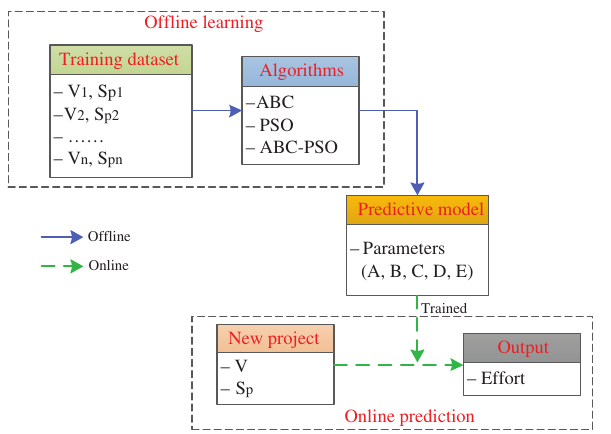
Figure 2: Flowchart of the Proposed Process.